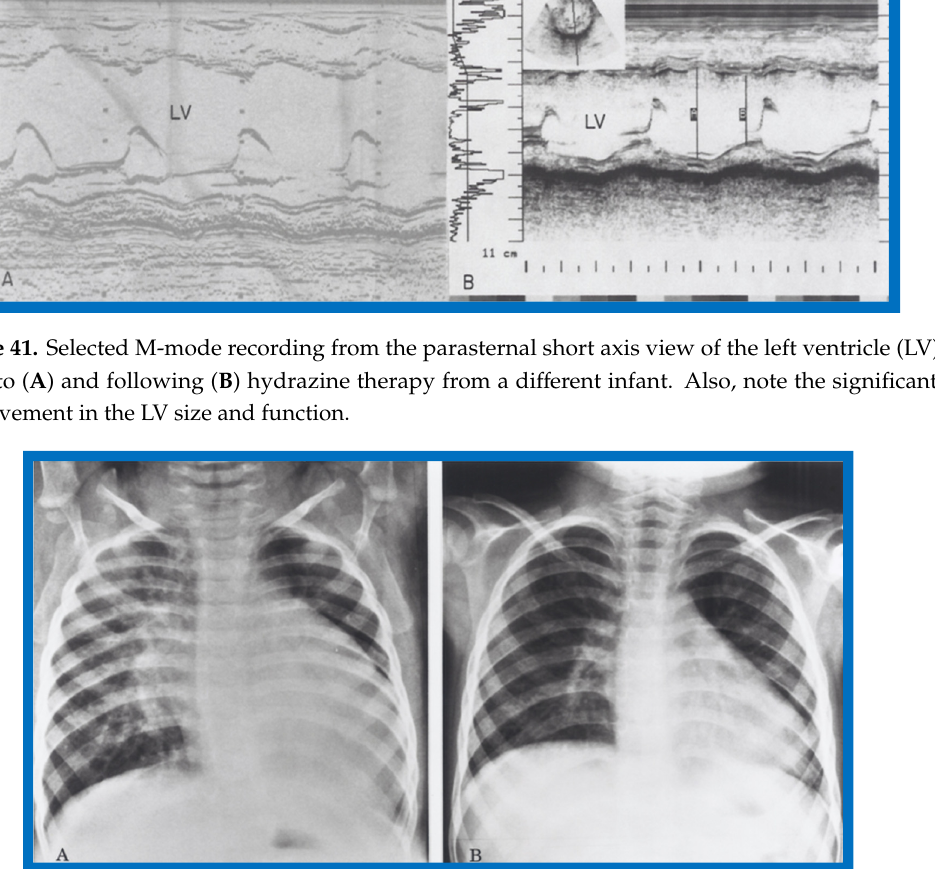
Figure 42. Antero-posterior view of chest x-rays prior to ( A ) and following ( B ) hydralazine therapy. Moderate cardiomegaly and pulmonary venous congestion were seen prior to therapy ( A ) which improved remarkably after therapy ( B ).